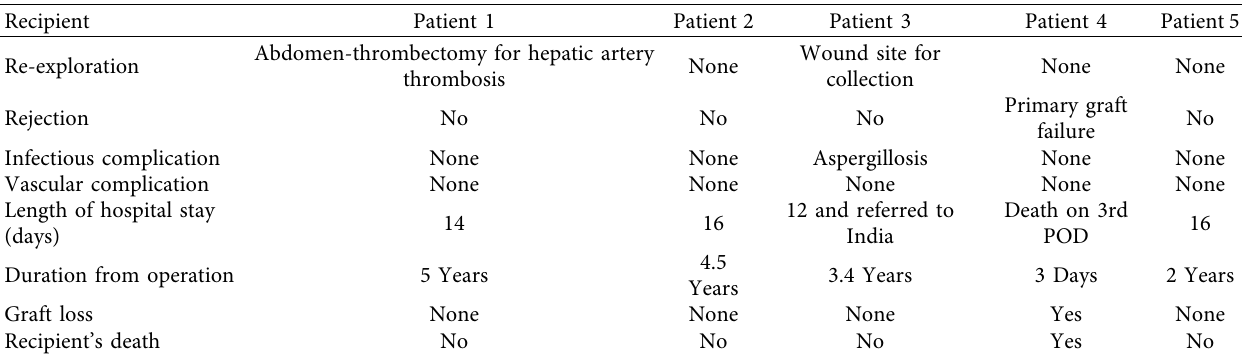
Figure 2: From right to left, Dr. Choon Hyuck David Kwon, Dr. Pukar Chandra Shrestha, Dr. Jae-won Joh, Dr. Neeraj Joshi, and Dr. Dong- Hyun Shin at the Samsung Medical Center, Seoul, South Korea, during the Nepalese team’s exposure visit. Table 2: Postoperative